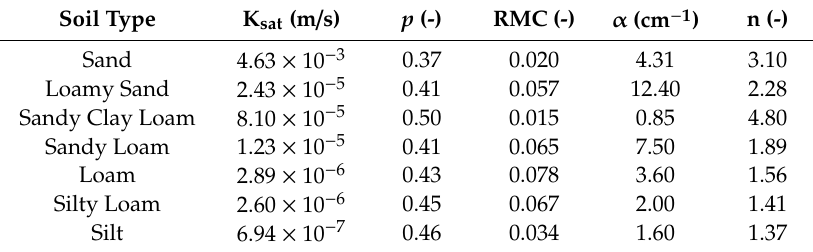
Table 1. Values of hydraulic properties used for numerical modeling derived by the VS2DTI catalog for generic soil textural classes based on the classification of United States Department of Agriculture (USDA) [68,69]. Key to symbols: K sat = saturated hydraulic conductivity; p = porosity; RMC = residual soil moisture content; α and n = van Genuchten’s fitting